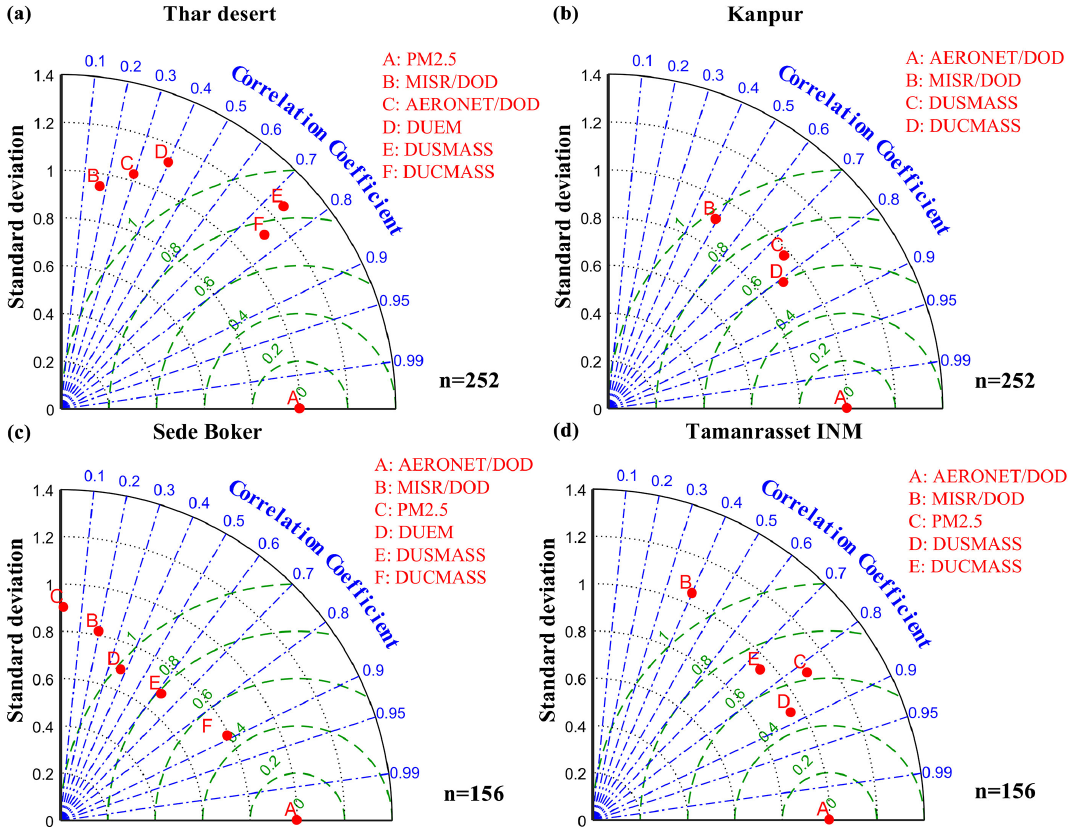
Figure 18. Normalized Taylor diagrams showing (a) the difference between dust variables acquired from the MISR, AERONET, and MERRA2 datasets and that acquired from the PM 2 . 5 dataset and (b–d) the difference between dust variables from the MISR, PM 2 . 5 , and MERRA2 datasets and that acquired from the AERONET dataset. The normalized standard deviation is on the radial axis (black contours), the correlation coefficient is on the angular axis (blue contours), and the green dashed lines indicate the centered RMSE. N indicates the sample